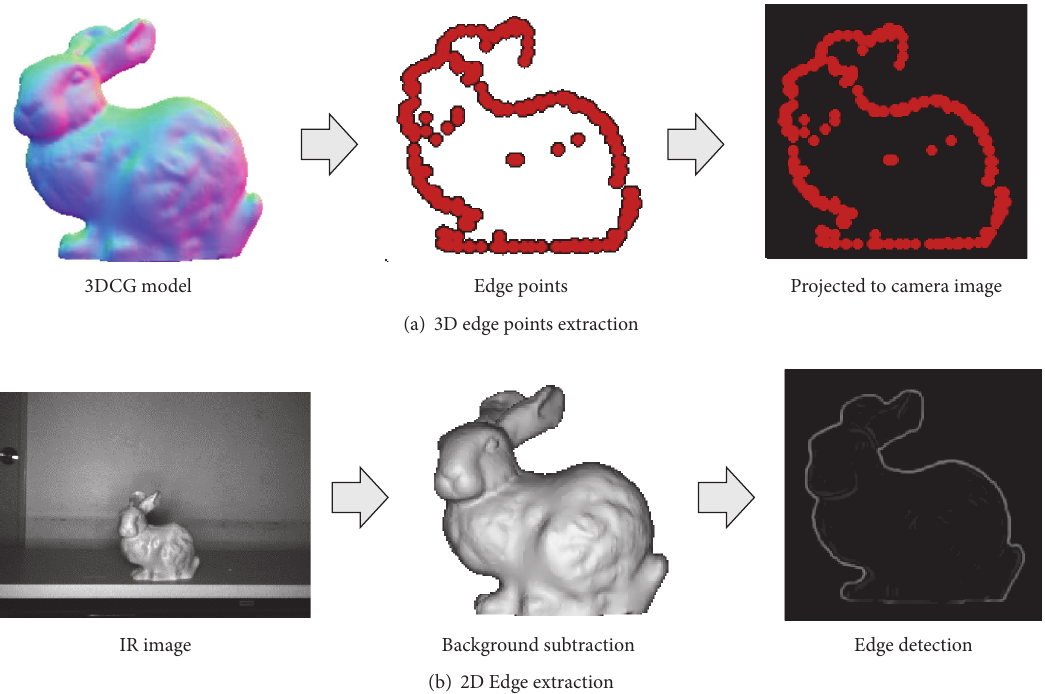
Figure 4: Detection of 3D edge points and 2D edges.